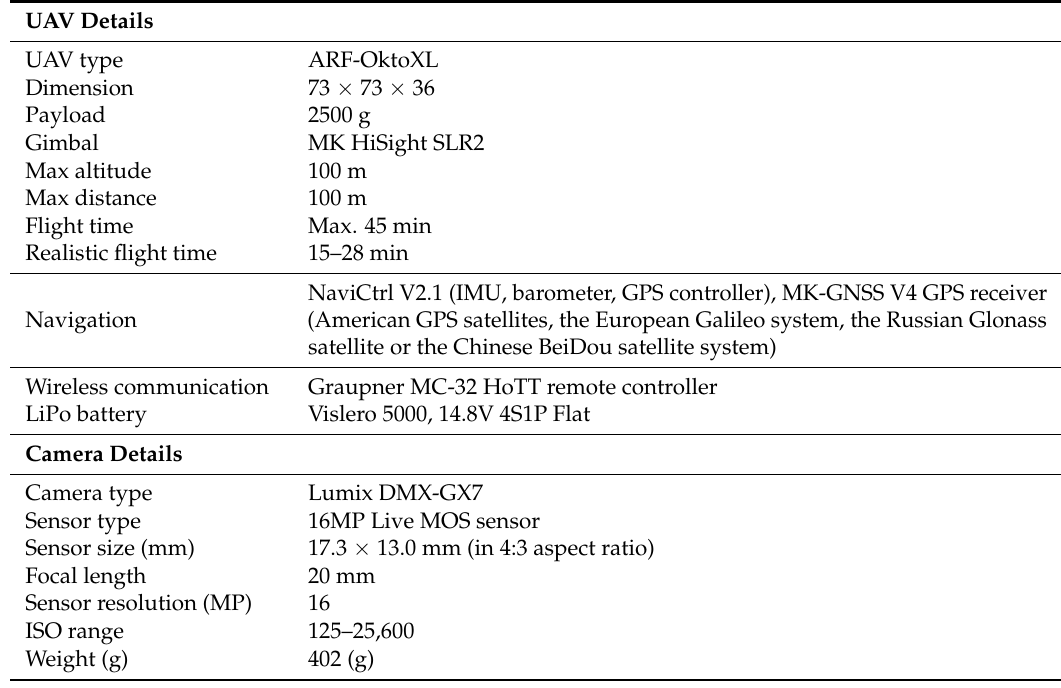
Table 1. Details about the applied unmanned aerial vehicle (UAV) and camera system.